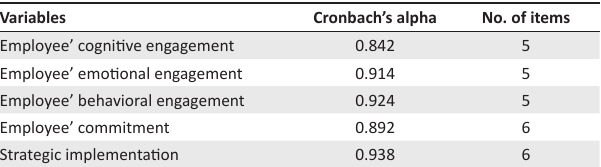
TABLE 1: Cronbach’s